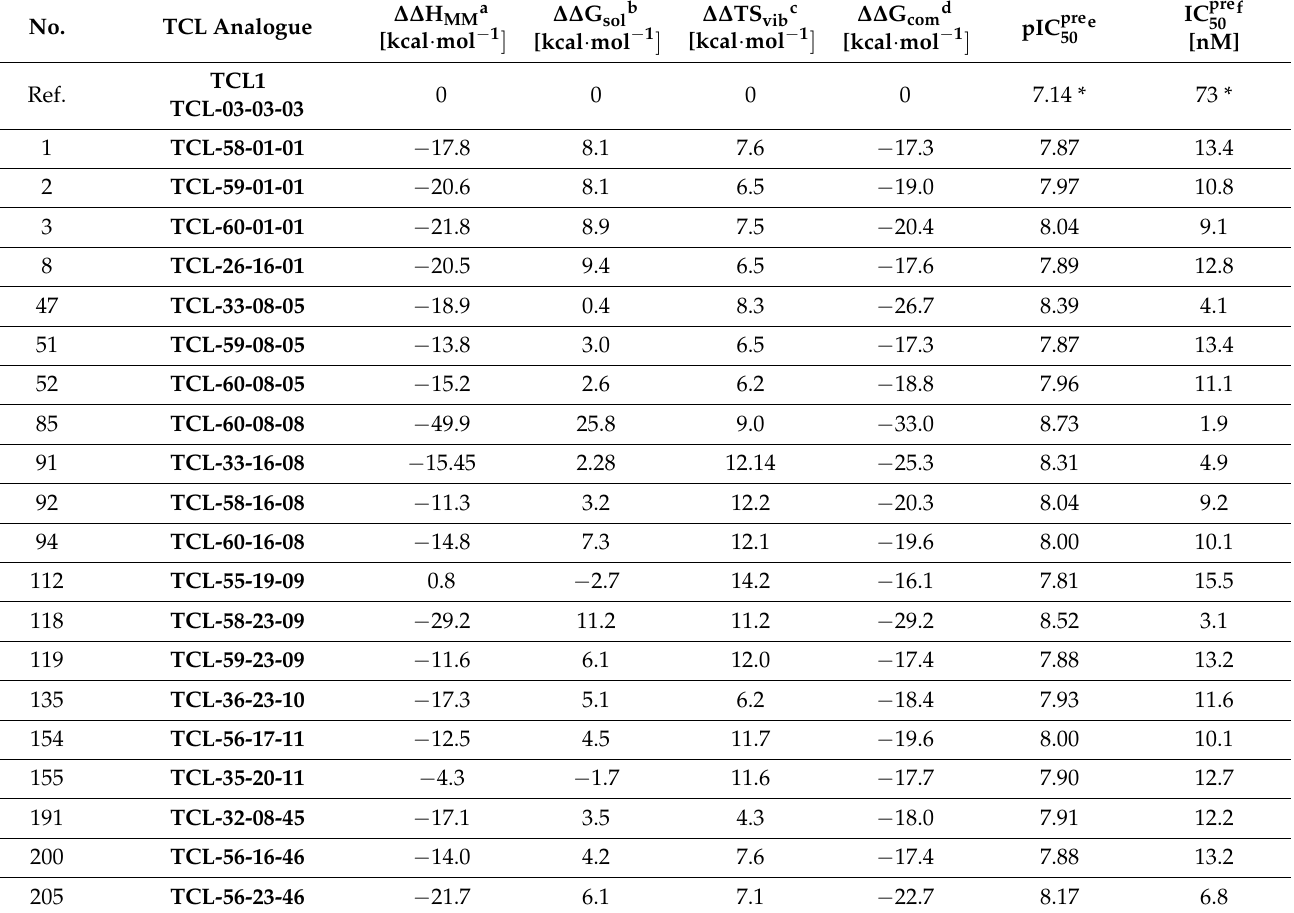
Table 6. Relative GFE calculated and its components for 20 best analogues of TCLs identified by in silico screening of the diversity combinatorial library. The numbering of the analogues concatenates the index of each substituent R 1 − R 2 − R 3 with the substituent numbers taken from Table